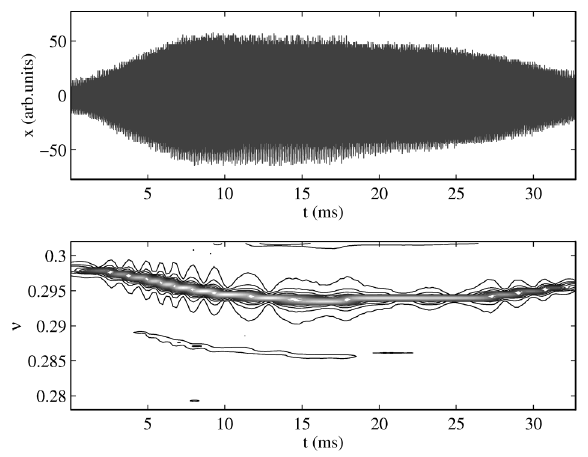
L (cid:1) 1 : 8 m (cid:6) 2 . 2